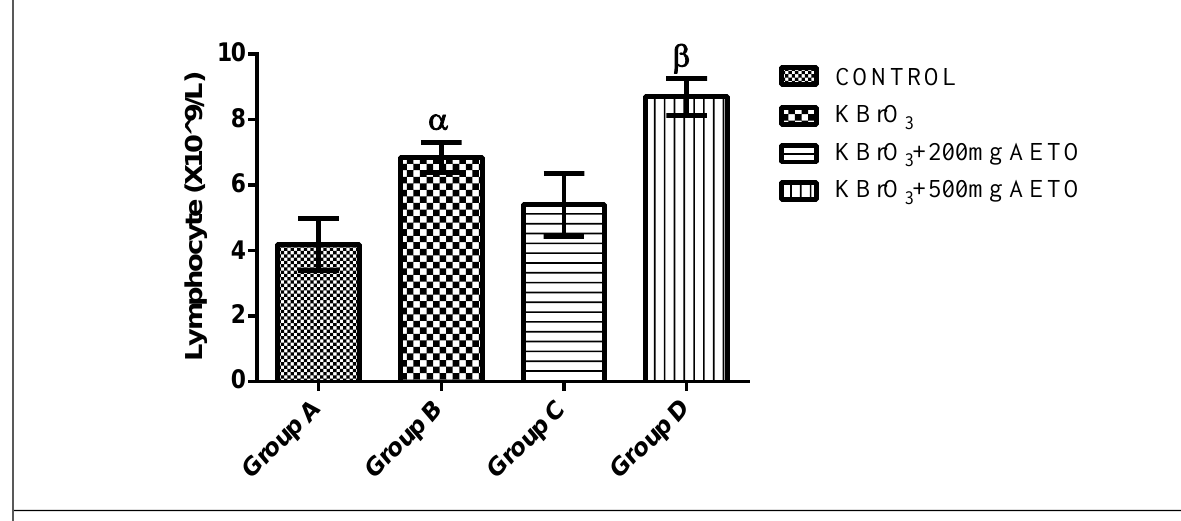
Figure 8: Effects of AETO on serum lymphocyte count